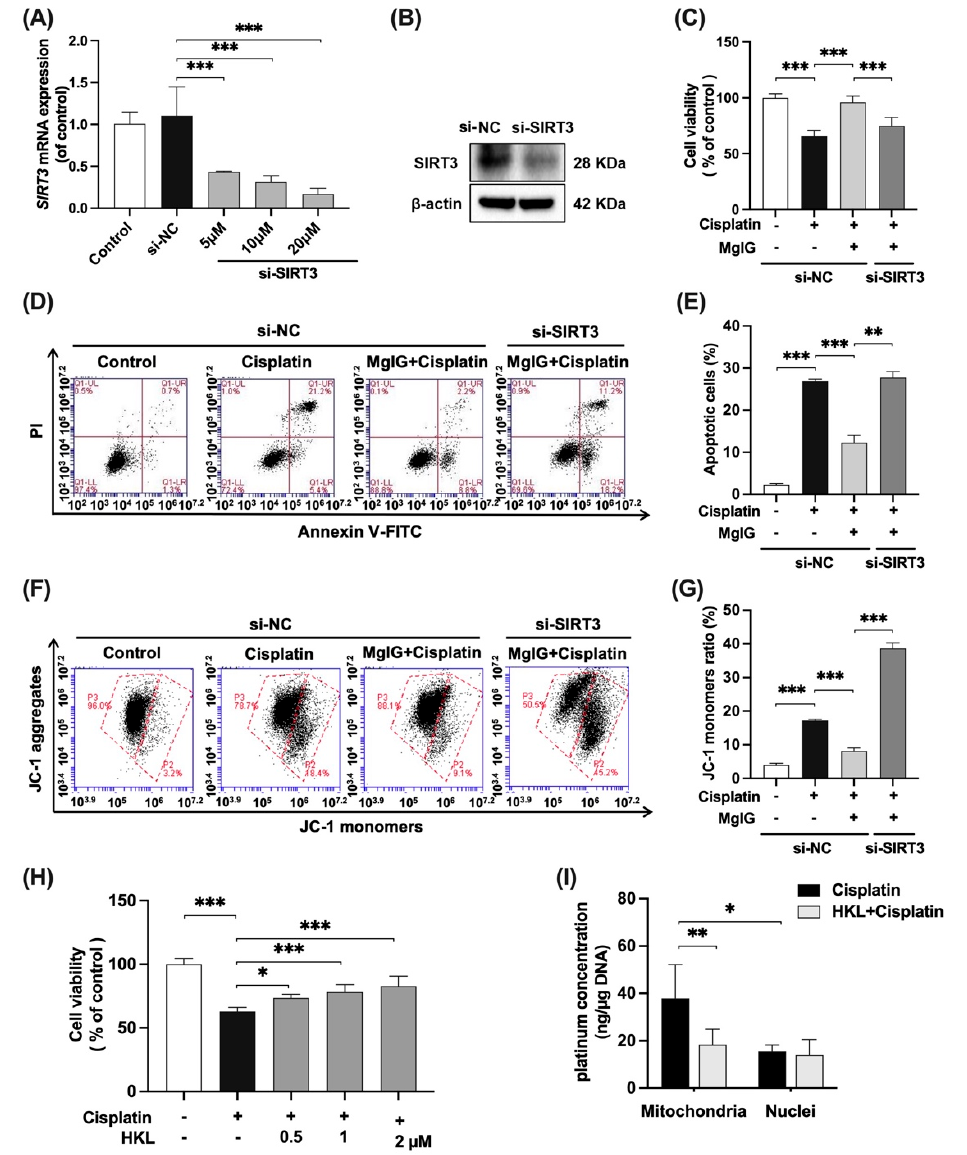
Figure 6. SIRT3 mediates the protective effect of MgIG on mitochondrial dysfunction induced by cisplatin. SIRT3 was knocked down in HK-2 cells by transferring siRNA. ( A , B ) The mRNA and protein expression levels of SIRT3 in HK-2 cells, n = 3. ( C – G ) The cell viability, representative images of apoptosis, and JC-1 staining of HK-2 cells from the indicated groups, comparing SIRT3 knockdown with the si-NC group, and quantitative results, n = 4. SIRT3 knockdown weakened the protective effect of MgIG combination from cisplatin in HK-2 cells. ( H ) The cell viability of HK-2 cells treated with cisplatin and HKL, n = 5. HKL mitigated the proliferation inhibition of HK-2 cells against cisplatin. ( I ) The effect of HKL on the amount of platinum–mtDNA adducts and platinum–nDNA adducts, n = 5. HKL specifically reduced platinum–mtDNA level. The data are presented as the mean ± SD. * p < 0.05, ** p < 0.01, *** p < 0.001.